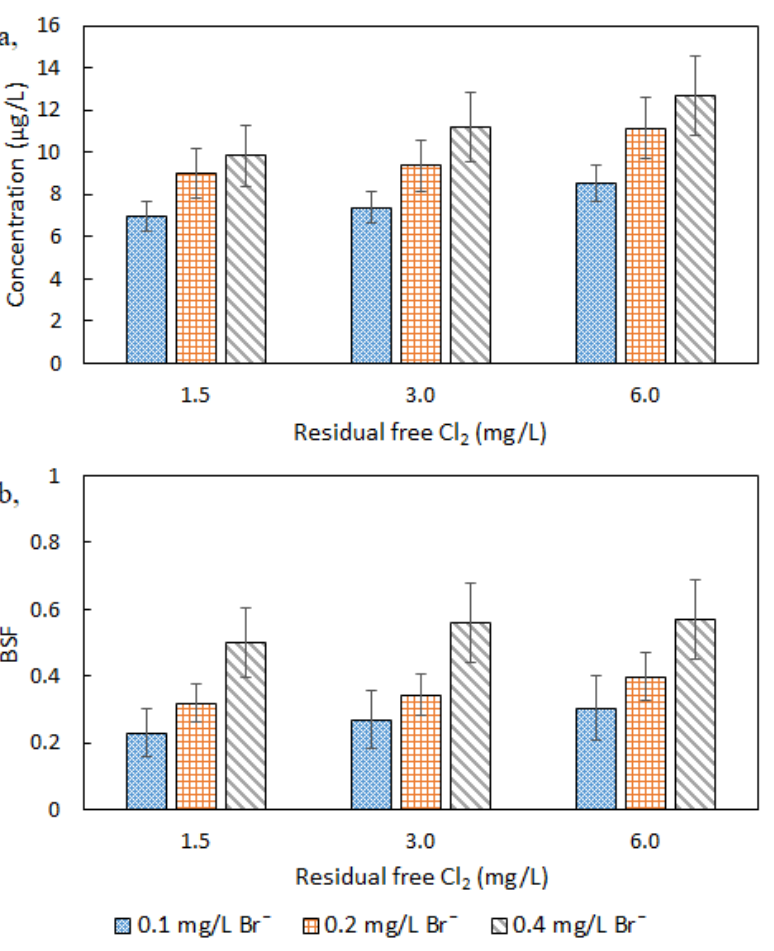
Figure 4. Effect of Br − concentration and residual free Cl 2 in raw water on the ( a ) concentration and ( b ) distribution of THMs during BC.